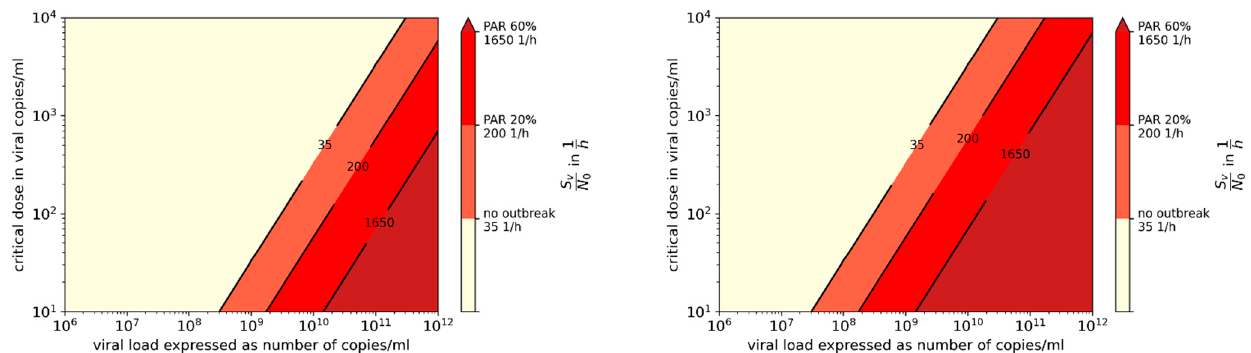
Figure 7. Virus factor for different viral loads and critical doses with a particle emission rate of 100 P/s, ( left ) and 1000 P/s ( right ); the attack rates found in the investigated outbreaks are shown with different colors.